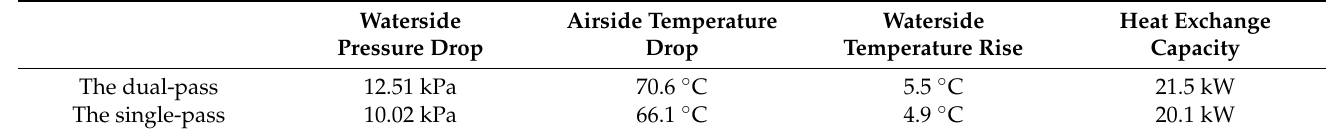
Figure 7. XY plane contours of single-pass water-cooled charge air cooler (K). Table 4. Simulation results of the charge air